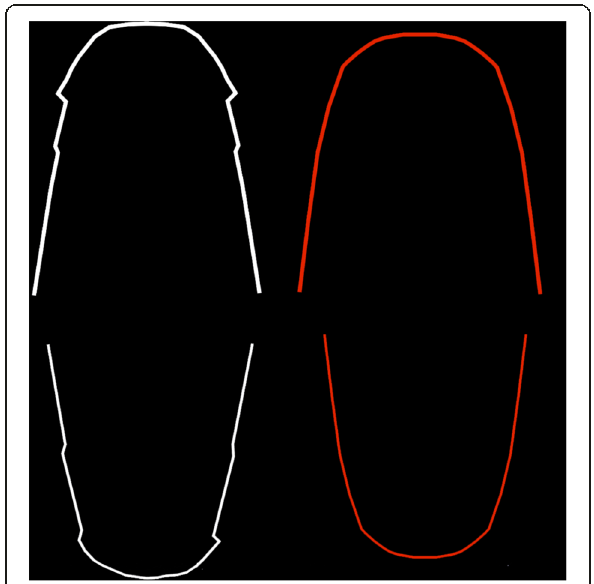
Fig. 2 Lingual mushroom and lingual straight archwires are generated by the same 3D virtual set up both for maxillary and mandibular arches